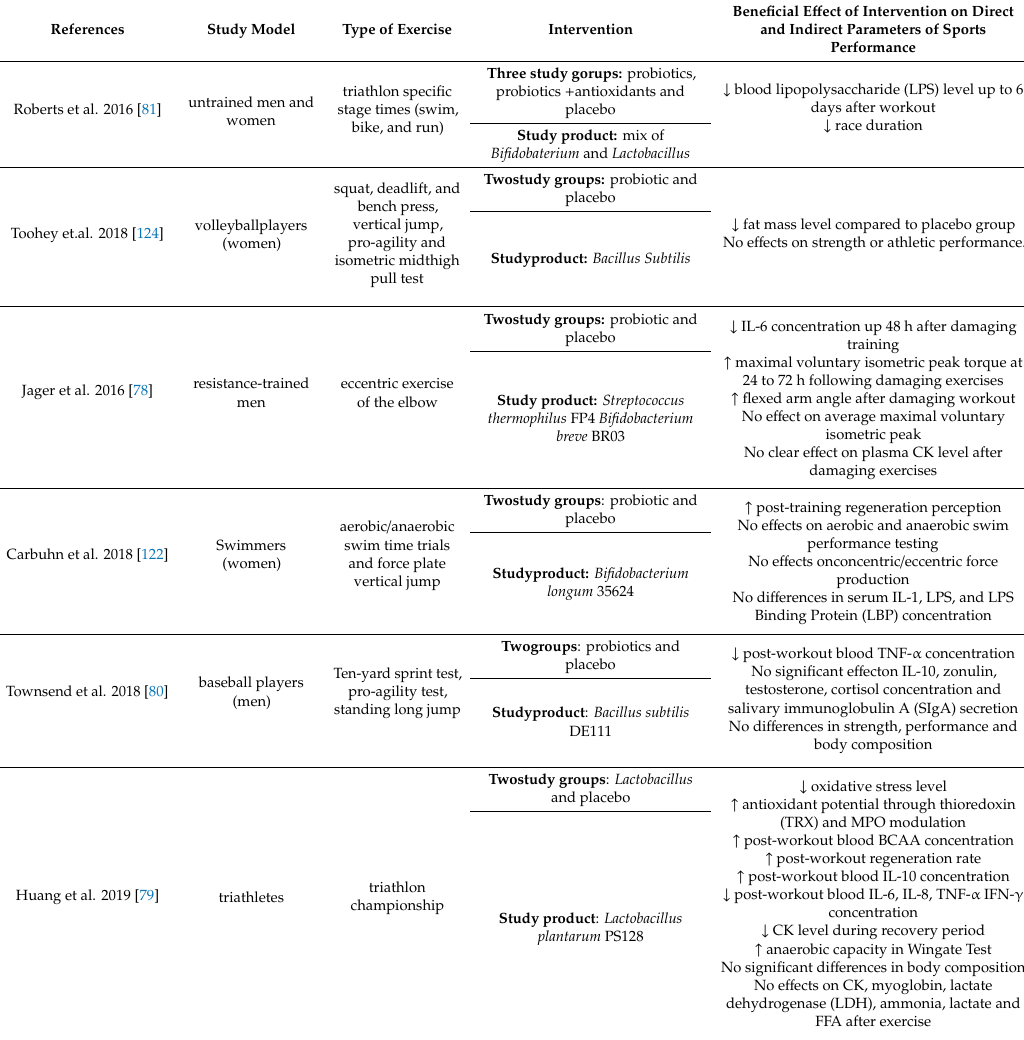
Table symbols: ↑ —increase; ↓